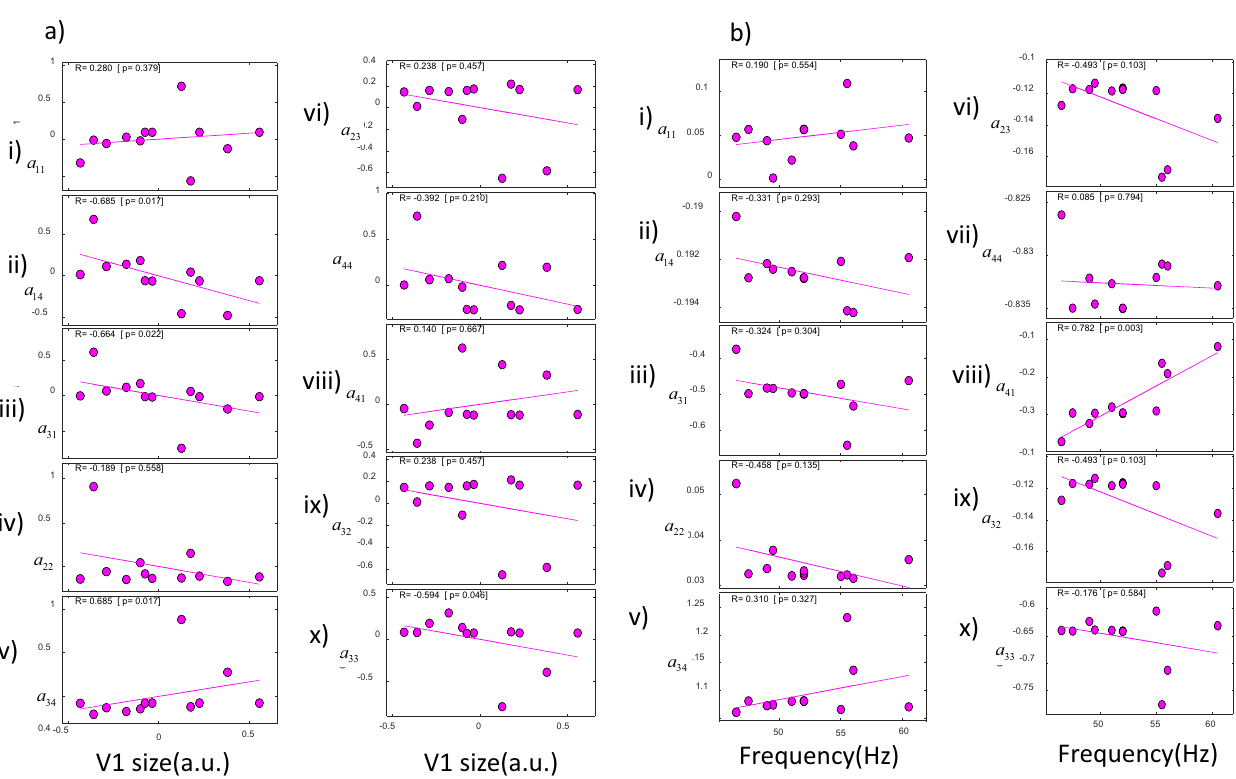
Fig. 4 Connection changes in data from ref. 20 . a Correlations between connectivity parameters and V1 size. Parameters were obtained by fi tting data from ref. 20 . Changes in the drive to deep pyramidal neurons from both super fi cial interneurons, a 31 (iii) and deep pyramidals, a 33 (x) correlated with V1 size. Also changes in the drive to deep interneurons, a 34 (v) and drive to inhibitory interneurons in super fi cial cells, a 14 (ii). b Correlations between connectivity parameters and gamma peak frequency. Parameters were obtained by fi tting data from ref. 20 . Changes to the drive to super fi cial pyramidal neurons correlated with peak frequency, a 41 (viii). Least-squares fi tted line shown in